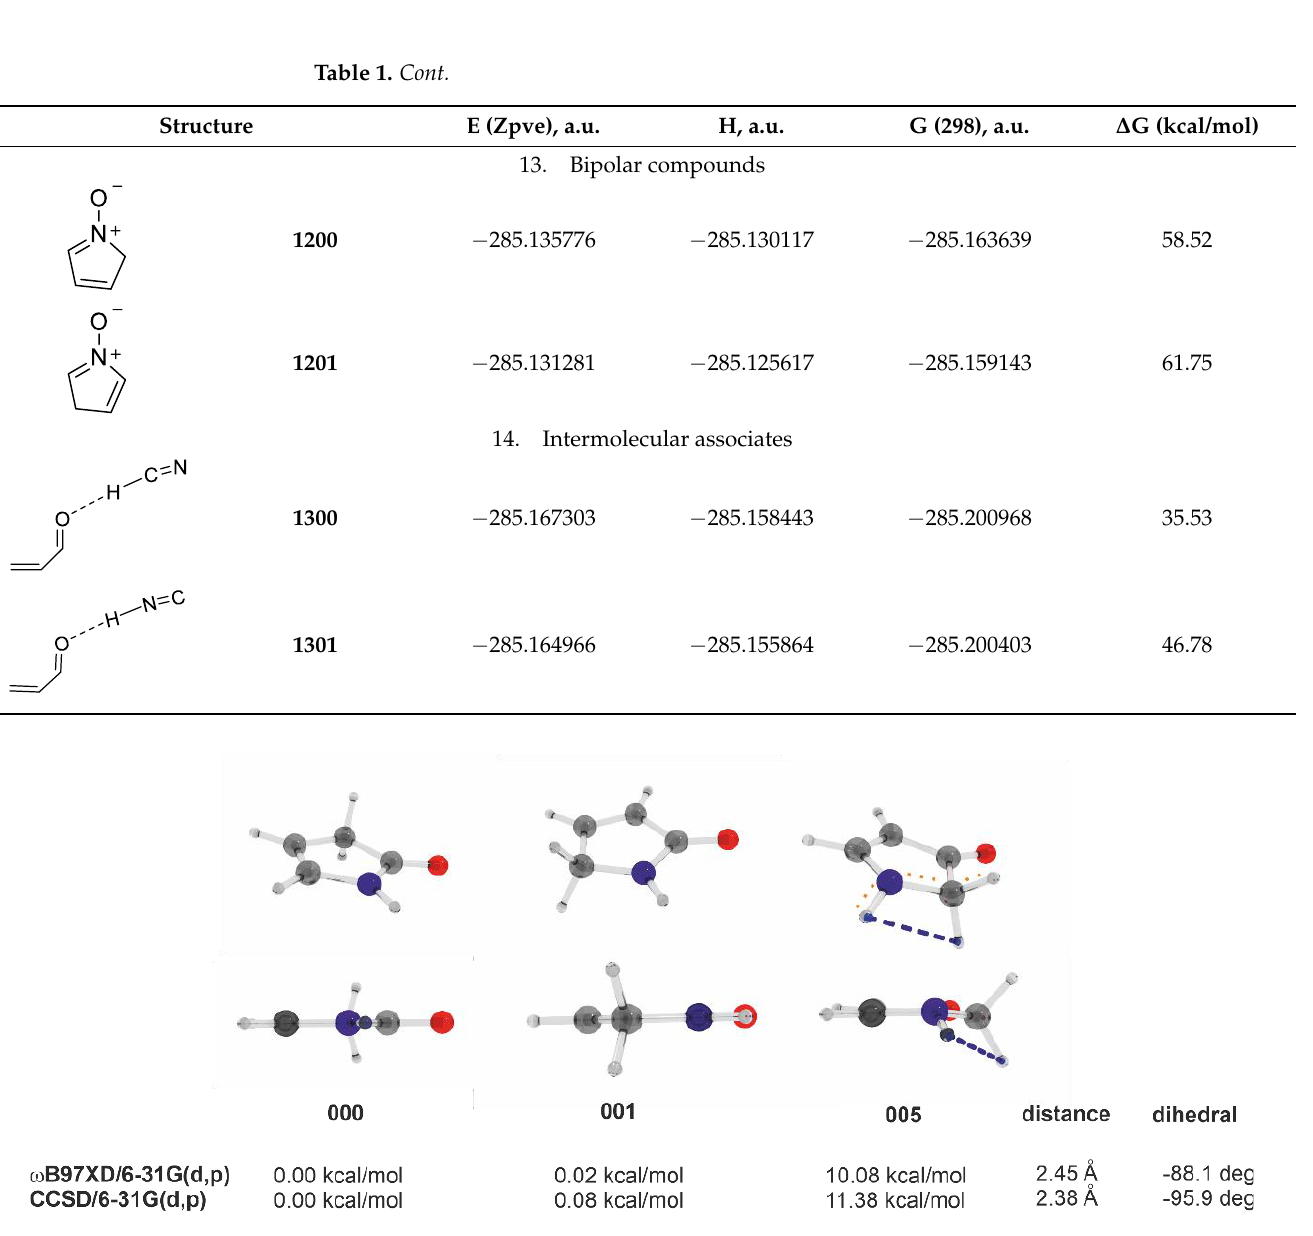
Figure 1. Relative Gibbs free energies and selected structural parameters for two “Guinness molecules” of C 4 H 5 NO and their unstable positional isomers. Hydrogen: light grey, Carbon: black, Nitrogen: blue, Oxygen: red. Table 1. Thermodynamic parameters of C 4 H 5 NO molecules with the lowest and highest energy within the structural group.